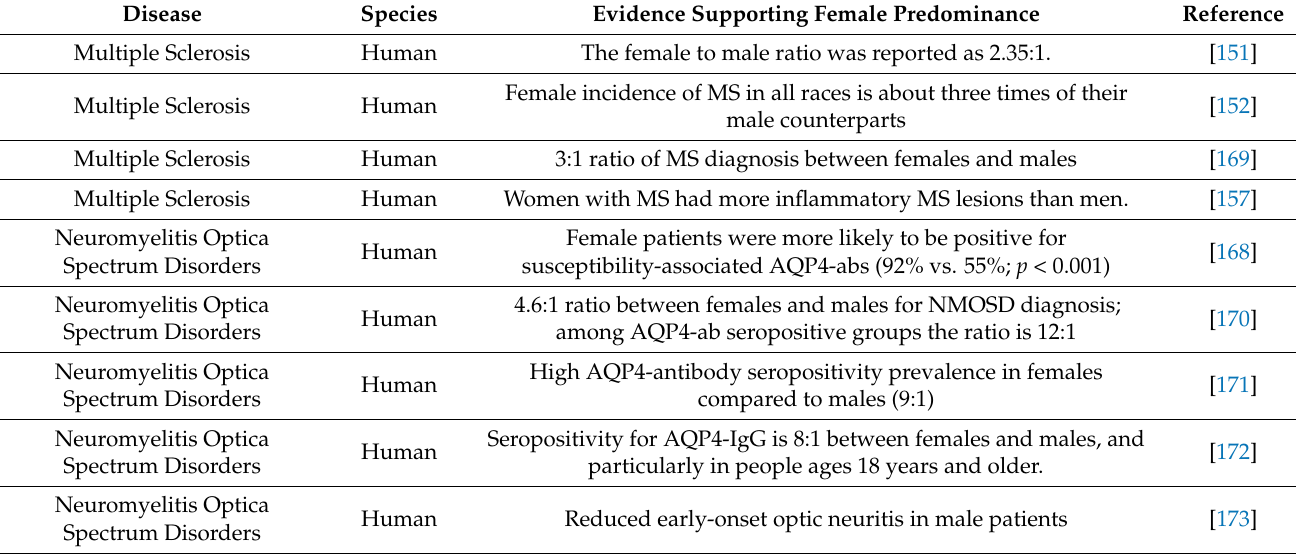
Table 2. MS and NMO are female